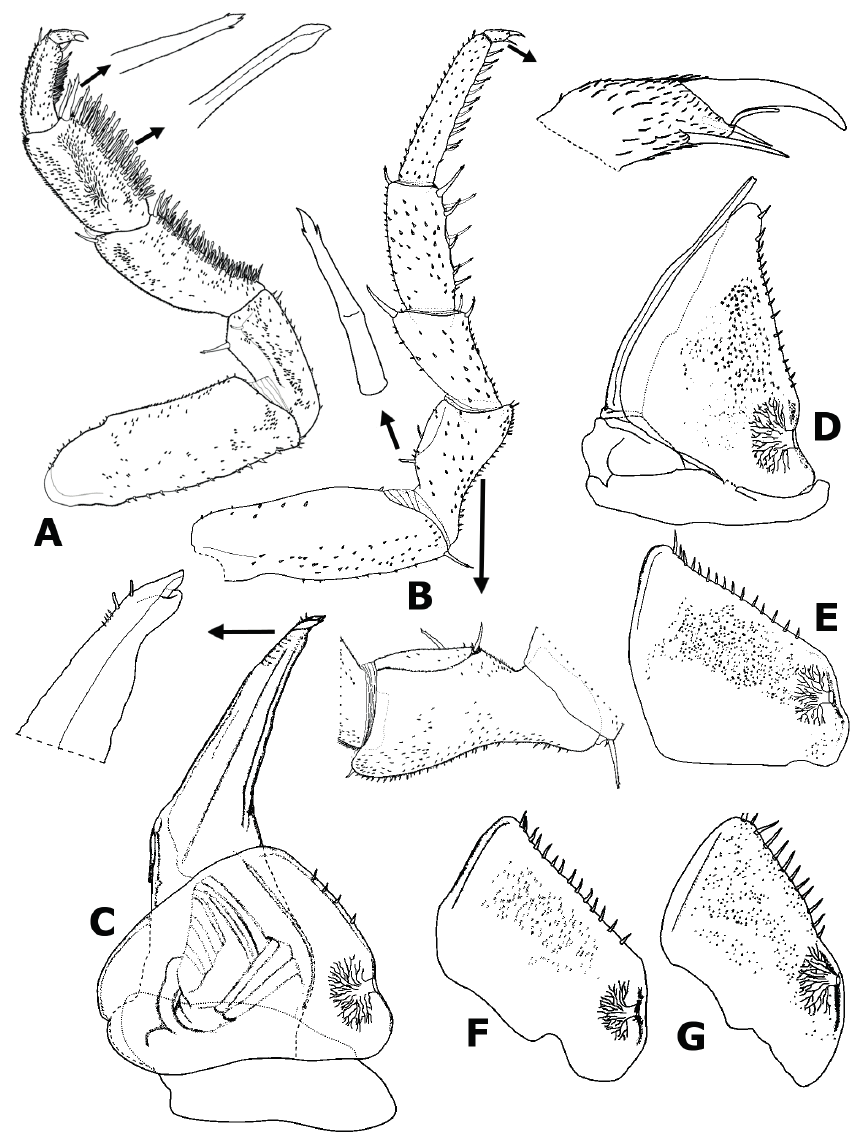
Figure 4. Pulmoniscus turbanaensis n. sp. ♂ Paratype (CUDC-CRU 13): A. Pereopod 1; B. Pereopod 7; C. Pleopod 1; D. Pleopod 2; E. Pleopod 3 exopod; F. Pleopod 4 exopod; G. Pleopod 5